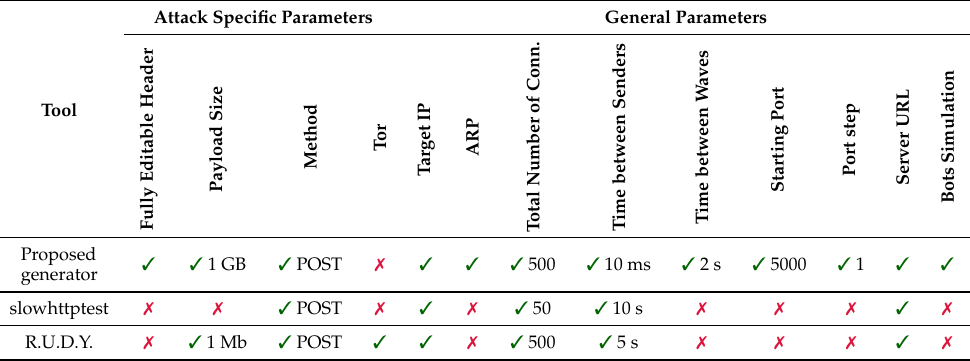
Table 5. Comparison of the proposed generator from the Slow POST attack point of view.